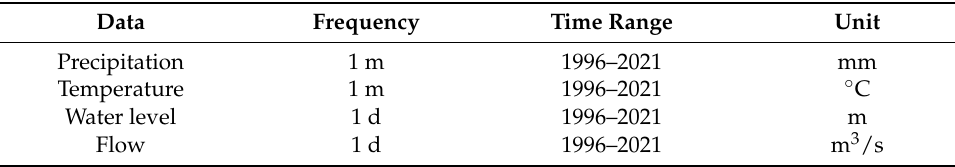
Table 2. The hydrometeorological data were used in this study. Data Frequency Time